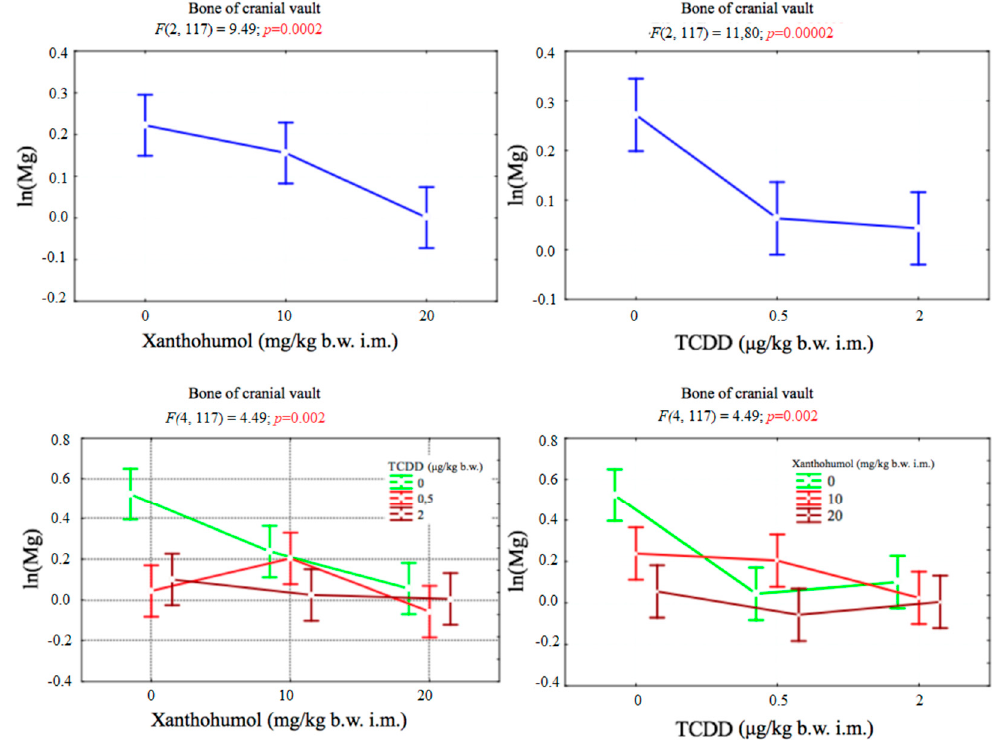
Figure 3. Average magnesium concentration (transformed variables) in the bone of the cranial vault, depending on the dose of TCDD and xanthohumol, and results of the significance test. Results are represented as mean ± SD. p ≤ 0.05 was considered statistically significant. Significant p value is highlighted in bold .